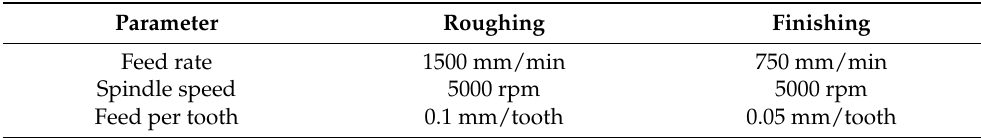
( b ) Figure 12. Machining and measuring of the workpiece: ( a ) machining on a three-axis machining center; ( b ) measuring on CMM using a Renishaw SP25M scanning probe.